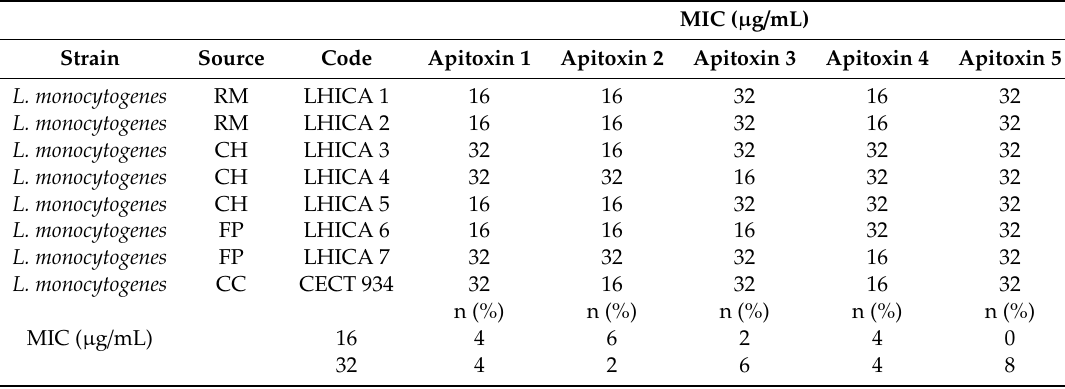
Table 2. Minimum inhibitory concentrations of five apitoxins tested in eight L. monocytogenes strains isolated from foodstu ff